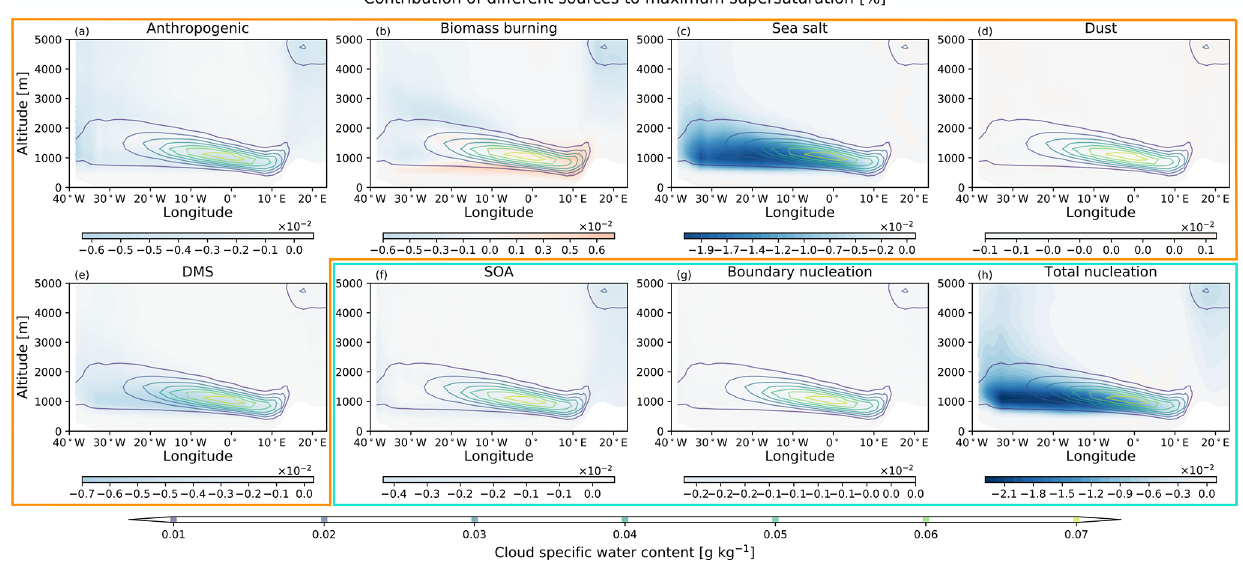
Figure 6. UKESM1-simulated annual mean vertical profiles of maximum supersaturation (%) from different sources. Profiles are averaged along the latitudes of the cloud box. The contributions of different sources to maximum supersaturation are listed in subplots (a) to (h) , where the contribution of emissions is shown using the orange frame, and the contribution of atmospheric processes is shown using the teal frame. The contour lines in each subplot are the cloud specific water content from the baseline simulation at the same temporal and spatial average. The same colour map scale is used in each subplot to facilitate comparison, but the range differs in each plot, corresponding to the maximum and minimum of the maximum